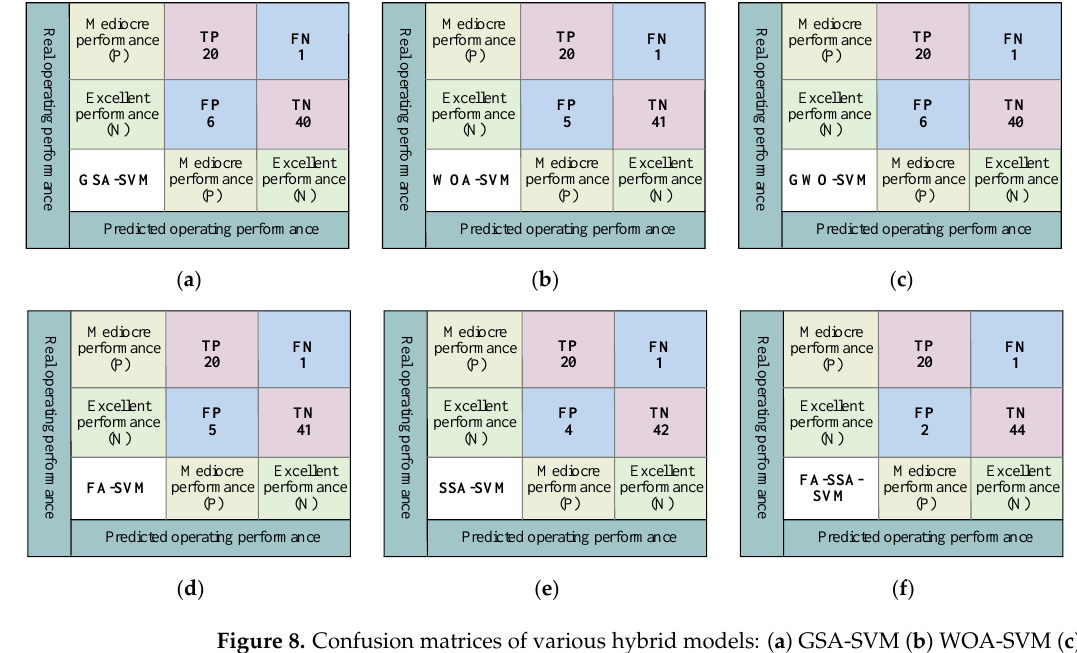
Figure 8. Confusion matrices of various hybrid models: ( a ) GSA-SVM ( b ) WOA-SVM ( c ) GWO-SVM ( d ) FA-SVM ( e ) SSA-SVM ( f ) FA-SSA-SVM.